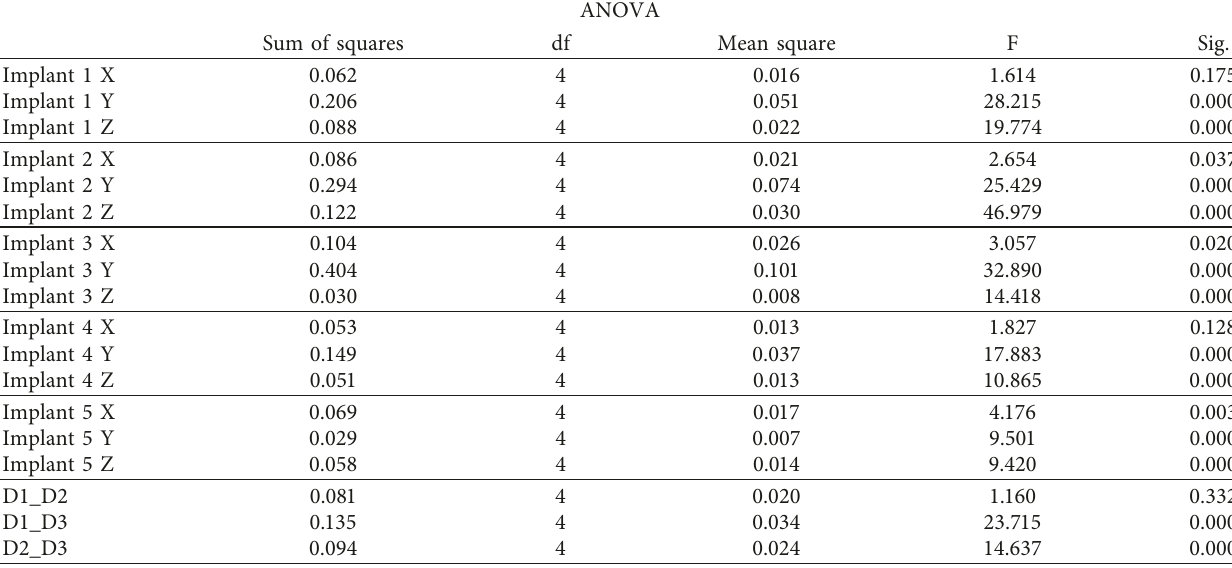
Table 4: The results of one-way ANOVA between all groups in comparison with the true value for implants and interarch distances. ANOVA Sum of squares df Mean square F Sig.